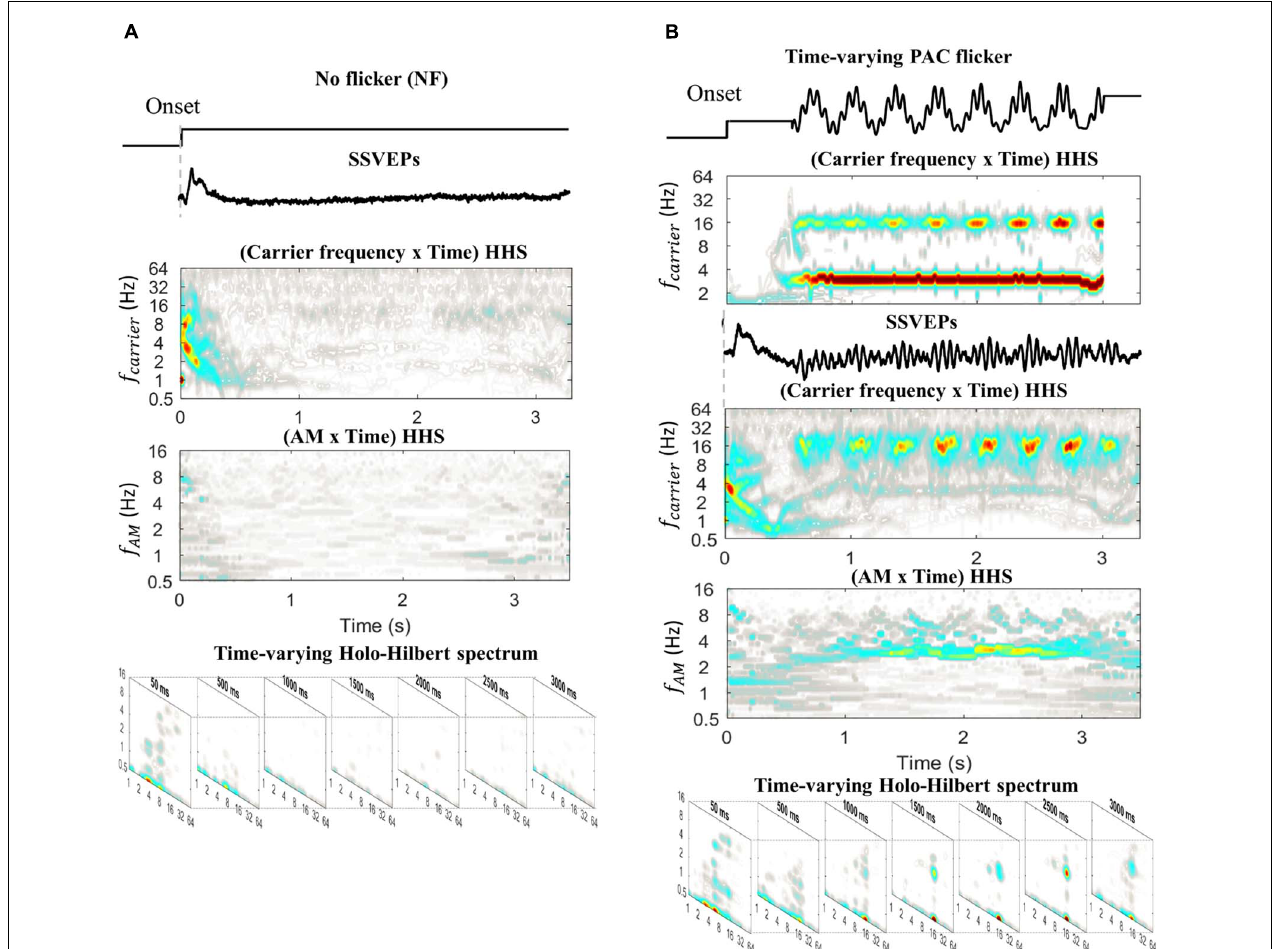
FIGURE 9 | The SSVEPs elicited by no flicker and time-varying PAC flicker, averaged for each condition across subjects. (A) The HHT and time-varying HHS analysis of SSVEPs induced by no flicker. The amplitude spectra are unclear for both methods. (B) The HHT and time-varying HHS analysis of SSVEPs induced by time-varying PAC flicker. The amplitudes increased at 3 Hz AM modulating 16 Hz carrier corresponding to the stimulation